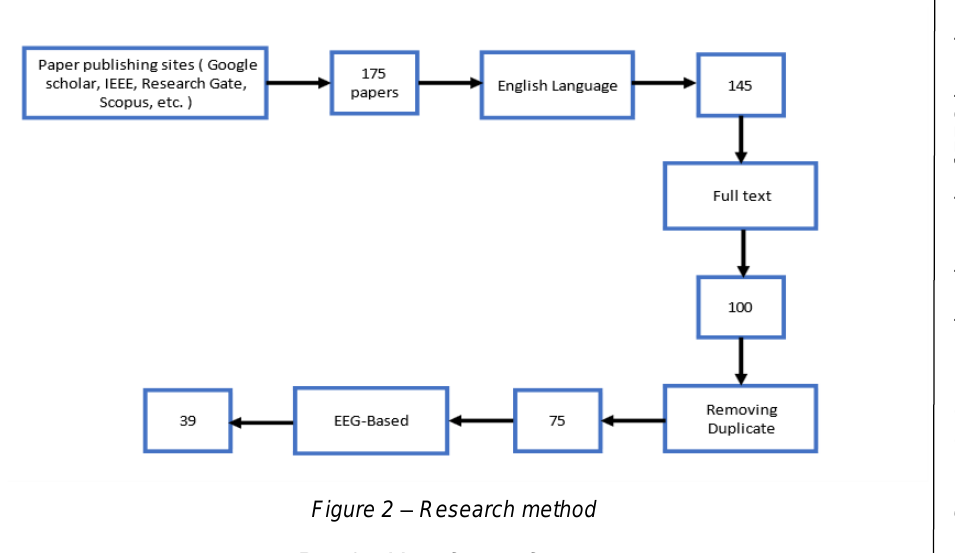
Figure 2 – Research method Рис. 2 – Метод